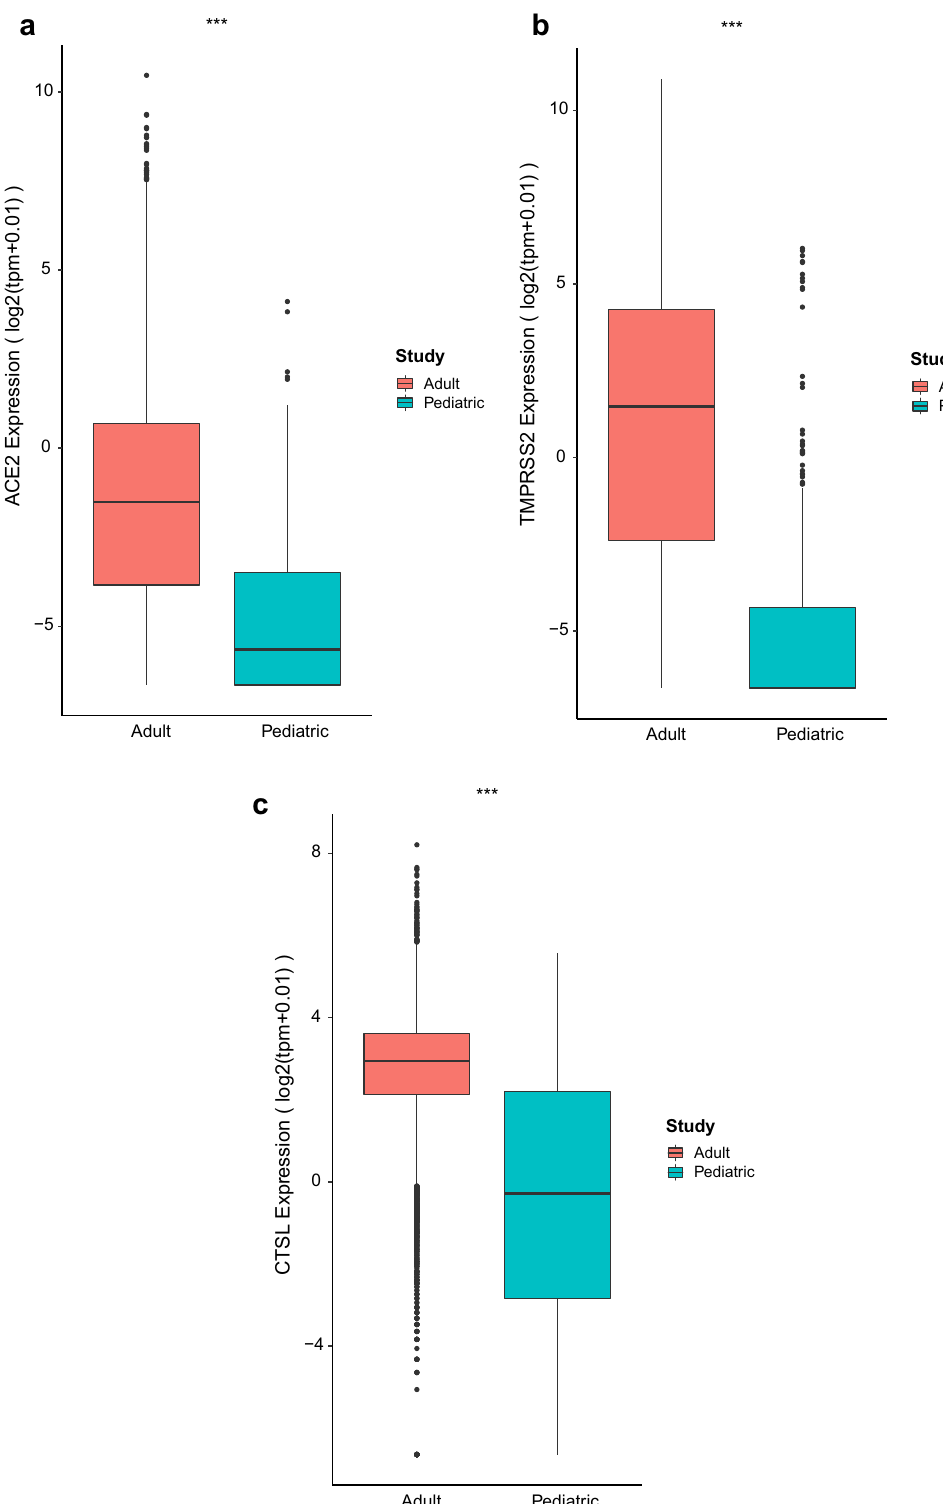
Figure 3. ACE2, TMPRSS2, and CTSL expression in adult and pediatric malignancies. Comparison of median ( a ) ACE2 , ( b ) TMPRSS2 , and ( c ) CTSL expression from 7 pediatric cancer tissues from TARGET (n = 734), and 33 cancer tissues from The Cancer Genome Atlas (TCGA, n = 10,535) was conducted. Gene expression is expressed as log 2 -transformed function of TPM. ANOVA with Tukey’s test was performed for comparison of expression between studies. *** p <